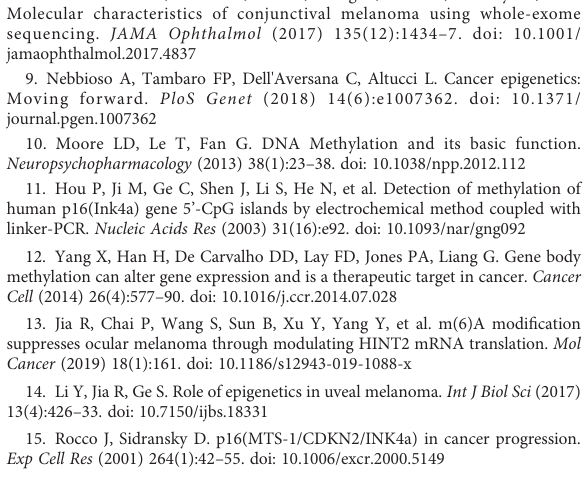
SUPPLEMENTARY FIGURE 1 The quality control analyses of samples from GSE57362. (A) PCA plot to visualize the relationship between UM and uvea samples. (B) Heatmap to exhibit the correlation among samples from GSE57362. (C) Heatmap to show the representative differential methylation CpGs between UM samples and normal uvea tissues. SUPPLEMENTARY FIGURE 2 The correlationbetweentheexpression ofDLL3 andthemethylationlevel of its corresponding CpGs. SUPPLEMENTARY TABLE 2 DEGs between metastatic UM samples and non-metastatic ones as well as DEGs between low and high DLL3 expression groups. SUPPLEMENTARY TABLE 3 The correlation between the DEGs expression level and their DNA methylation level in UM. * P < 0.05, ** P < 0.01. SUPPLEMENTARY TABLE 4 The methylation level of CpGs in DLL3 was positively associated with UM. SUPPLEMENTARY TABLE 5 The results of GO terms and KEGG pathways enrichment analyses as well as the results of GSEA of cancer